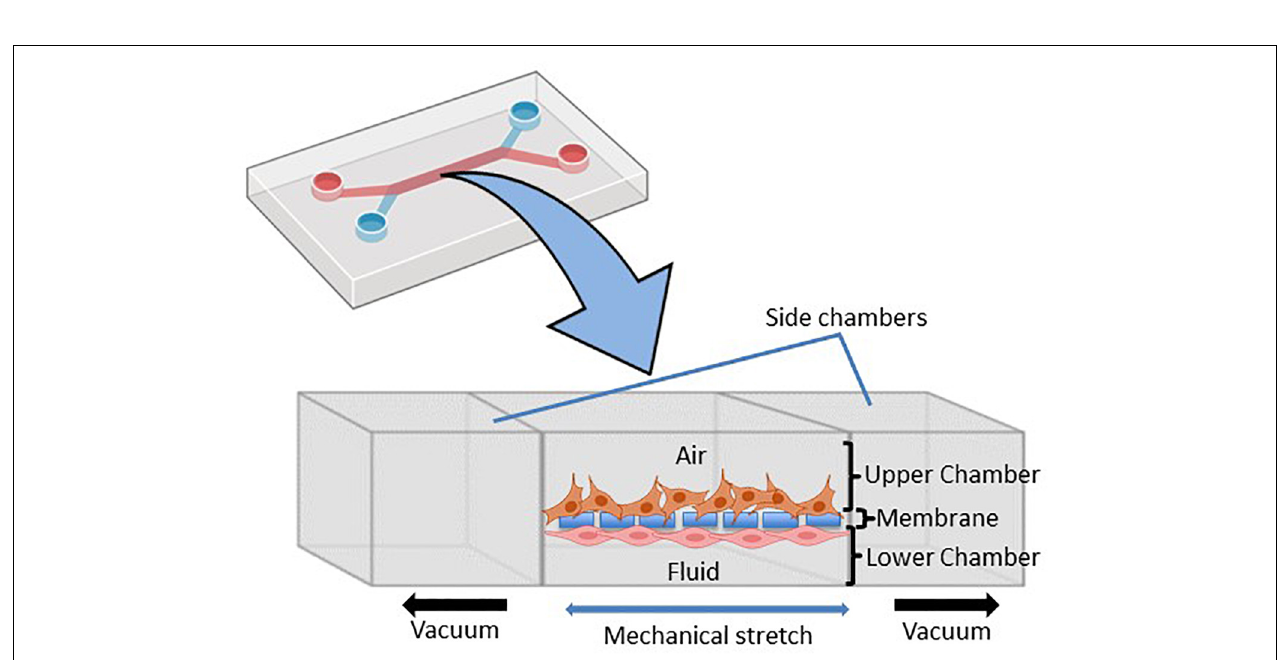
FIGURE 2 | Schematic representation of the microfluidic lung-on-chip (LOC) system. Cross-section through the LOC model displaying the upper chamber consisting of human lung epithelial cells and the lower chamber consisting of pulmonary endothelial cells divided by a thin porous membrane. Side vacuum channels stretch out the membrane and mimic in vivo breathing-like forces (adapted from Huh et al., 2010 and made in ©BioRender - biorender.com).